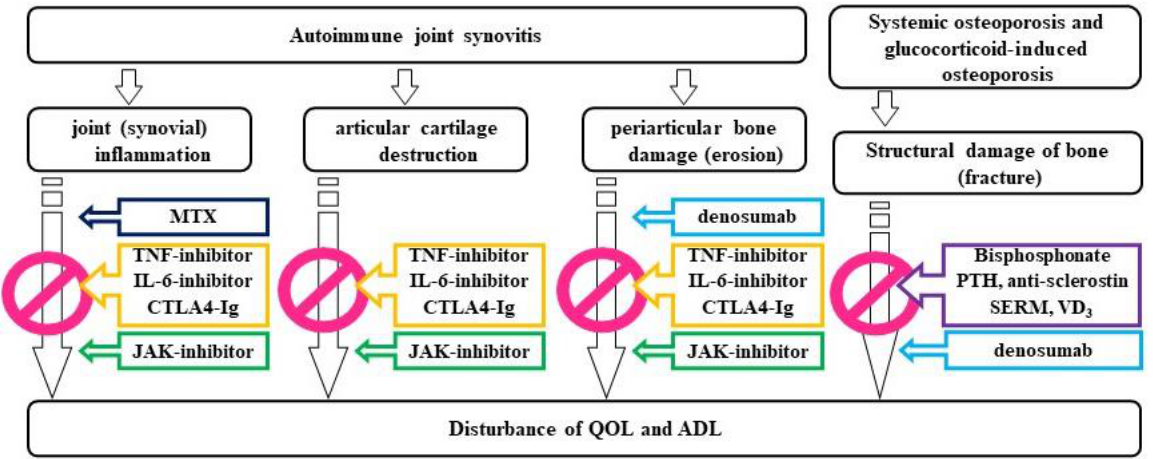
Figure 5. Osteoporosis, bone erosion, cartilage resorption, and synovial inflammation in rheumatoid arthritis, with their corresponding targets.